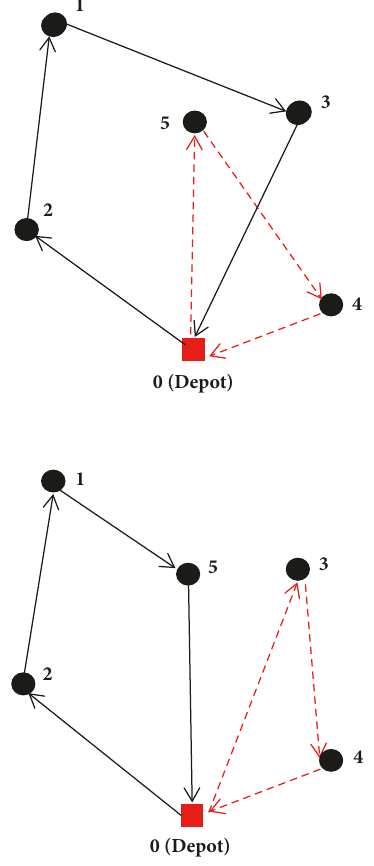
Figure 4: The example of mutation